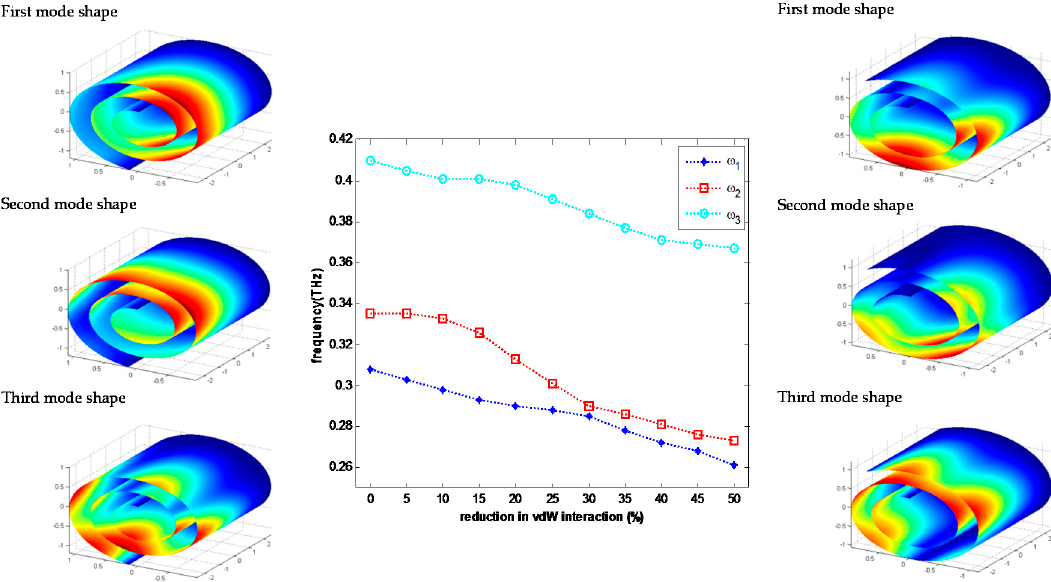
Figure 7. Variation of first three natural frequencies versus reduction in vdW interaction with FCSS boundary condition.